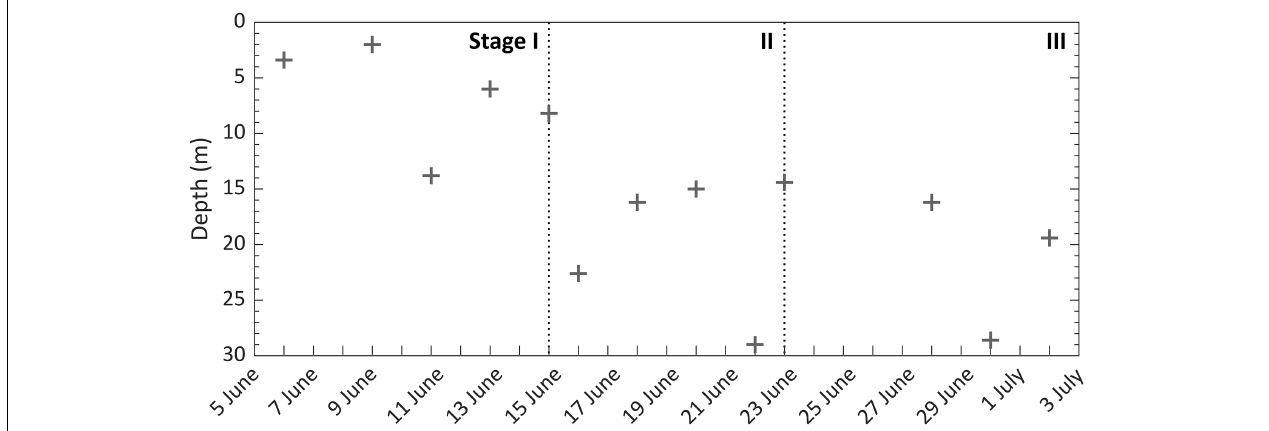
FIGURE 7 | Aggregate scale depth of PAR transmission beneath landfast sea ice over the melt season. The dotted line states the beginning of each melt stage (I–III).